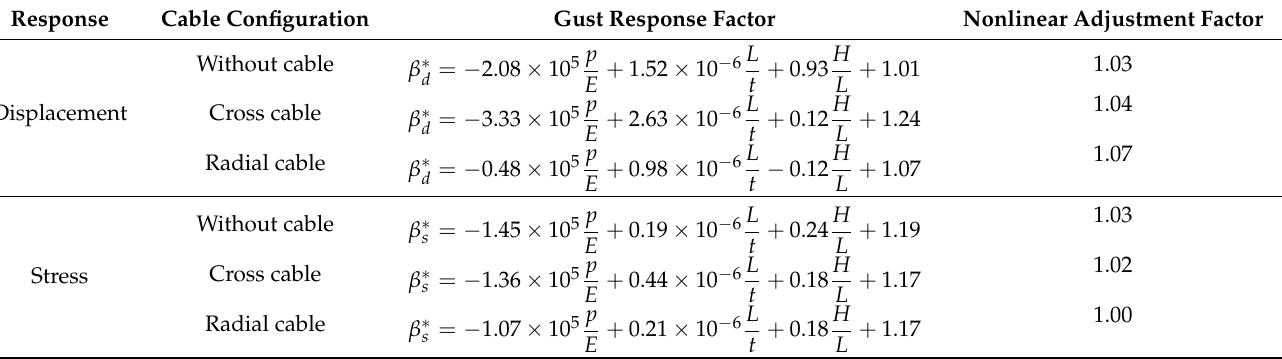
Table 6. Recommendations of gust response factors and nonlinear adjustment factors.